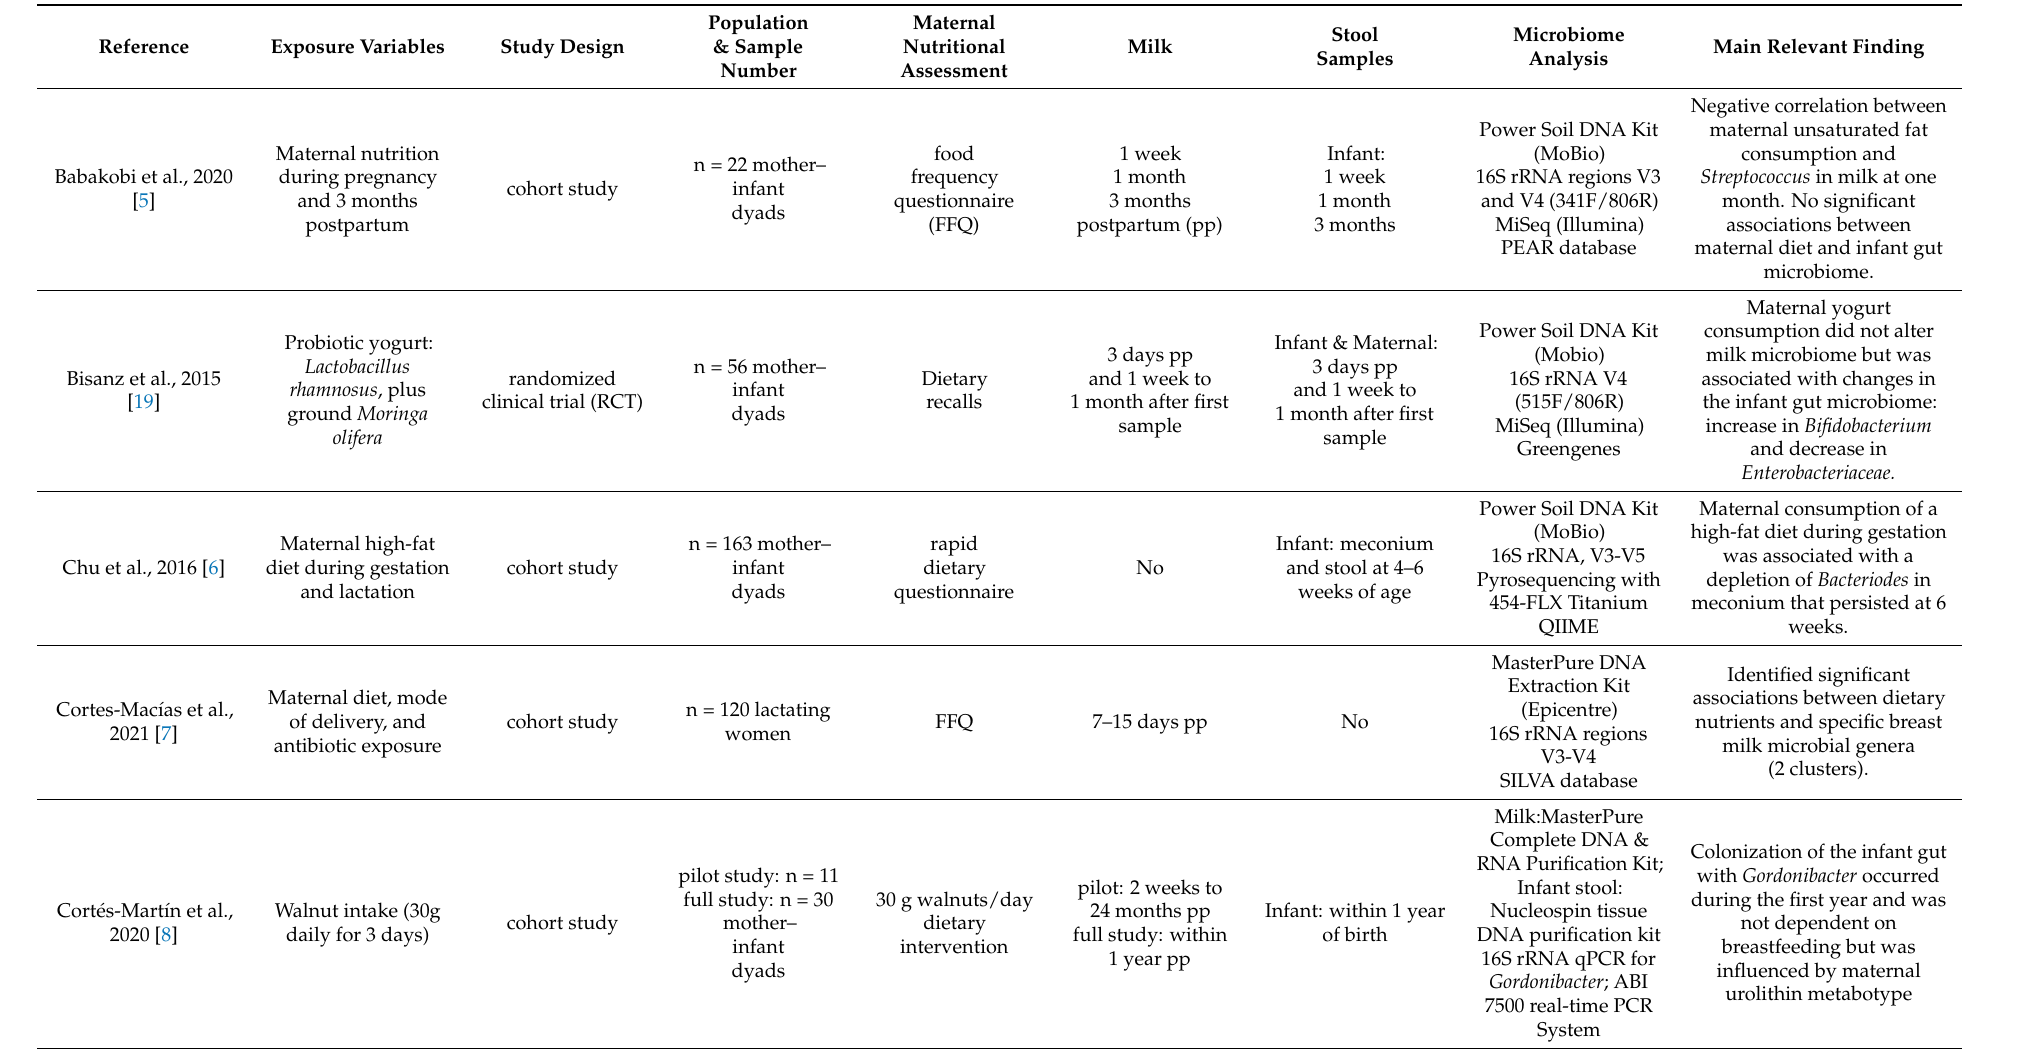
Table 2. Studies assessing the relationship between maternal diet and maternal or infant